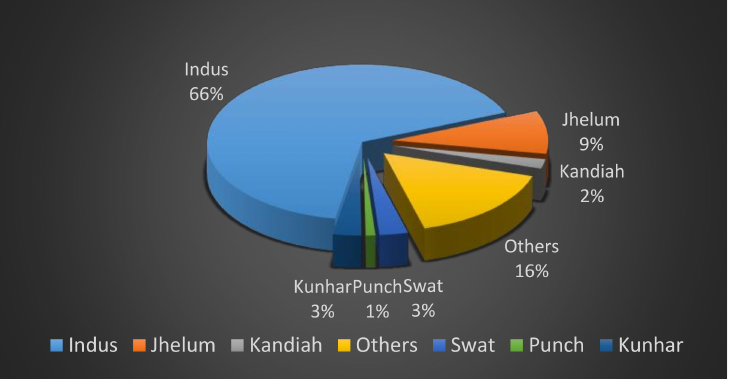
Figure 2. Identified hydro resources of Pakistan